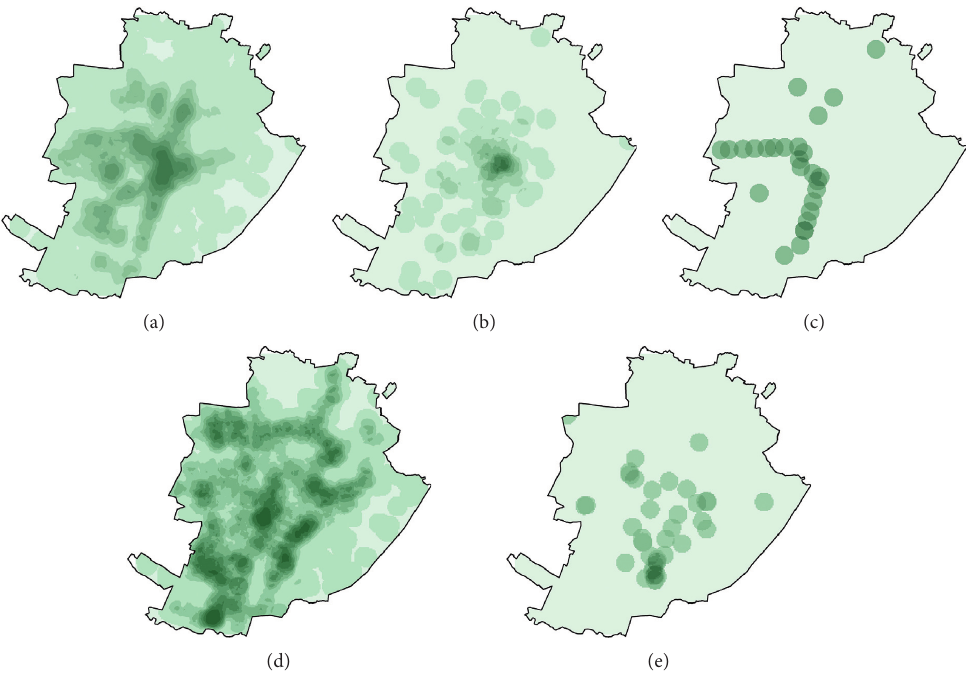
Figure 7: Five PCs: retail (PC1), Cultural Offer (PC2), Public Transport Station (PC3), Public Green and Sport Areas (PC4), and Public Healthcare (PC5) (source: author’s elaboration). (a) PC1. (b) PC2. (c) PC3. (d) PC4. (e) PC5.